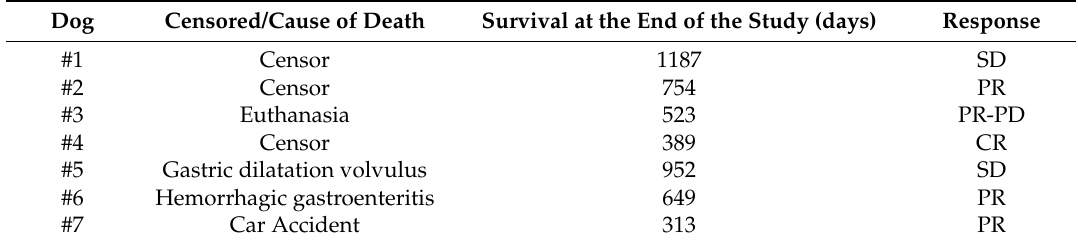
Table 3. Data regarding the Kaplan Meier analysis with indicated the cause of death or the type of censoring and the type of